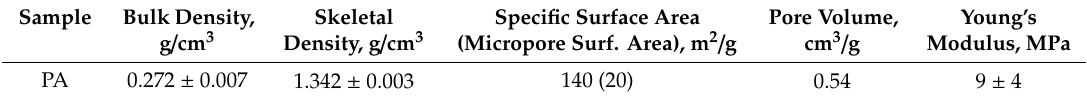
Figure 14. Differential ( а ) and recalculated ( b ) pore size distribution curves of the PA sample. Figure 14. Di ff erential ( a ) and recalculated ( b ) pore size distribution curves of the PA sample. Table 2. Measured characteristics of the PA